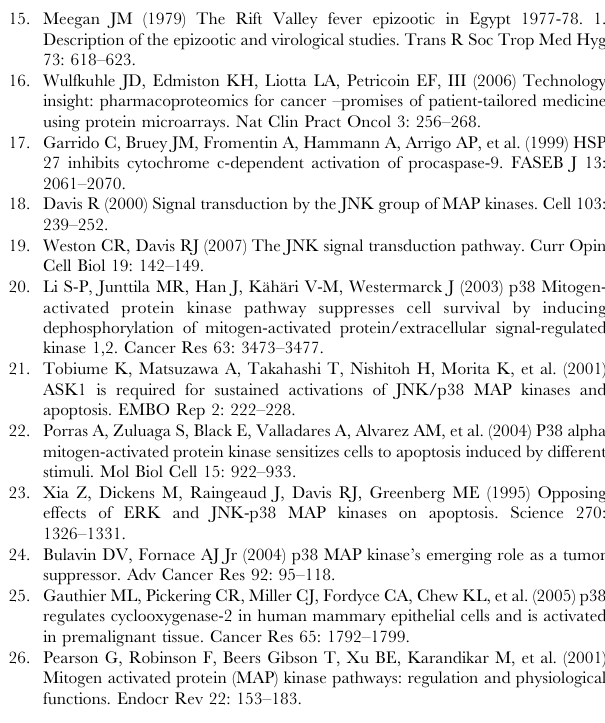
Figure S1 Induction of ERK1/2, p38, and JNK by RVFV MP- 12. Western blots were performed on lysates of RVFV MP-12- infected HSAECs at indicated times post infection with MOI of 0.002 (for ERK1/2, p38 and JNK). Open and grey bars show band intensities of uninfected and infected cells, correspondingly, calculated relative to uninfected cells at 24 h.p.i. Figure S2 Sub-G1 cell cycle fraction of HSAECs is increased during RVFV infection. HSAECs were mock infected or infected with RVFV MP12 at MOI of 3.0. Cells were collected at 6, 24, and 48 h.p.i. and cell cycle analysis performed by propidium iodide staining. Flow cytometry data were acquired on a Becton Dickinson FACScaliber with a 488-nm argon laser. Acquisition and analysis were performed with CELLQuest software. A. The percent of the sub-G1 population relative to the total number of cells as average of two independent samples. Open bars, mock- infected cells; gray bars, RVFV-infected cells. B. Histogram of the sample at 48 h.p.i. illustrating the position of the sub-G1 fraction gate. Found at: doi:10.1371/journal.pone.0013805.s002 (0.71 MB